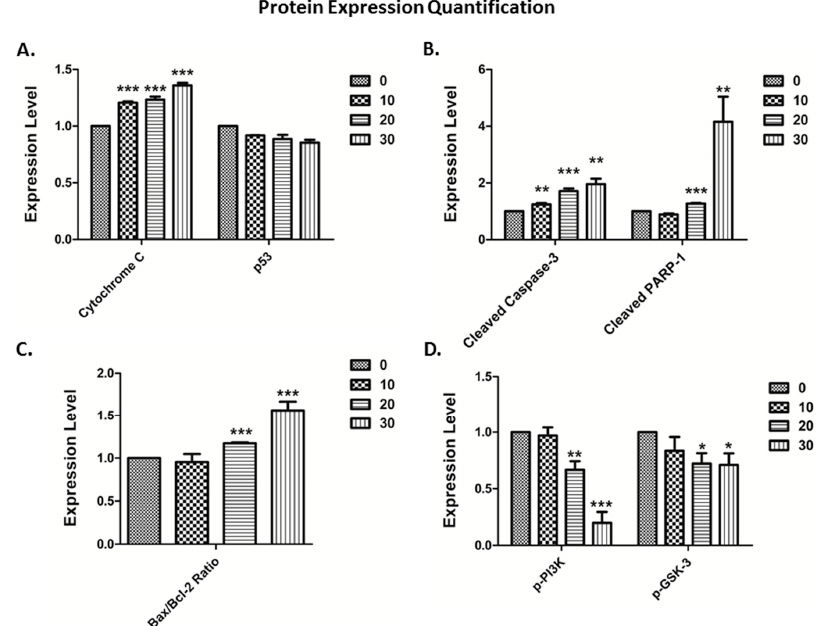
Figure 8. Quantification of apoptotic protein expression in MDA-MB-231 cells treated with beta-T3 vitamin E isomer for 24 h by the Image J software. Compared to control levels, beta-T3 significantly increased, on the one hand, cytochrome-c ( A ), cleaved caspase-3, cleaved-PARP-1 ( B ) and Bax/Bcl-2 ratio ( C ) expression levels. On the other hand, it significantly decreased the expression levels of two proliferation involved proteins p-PI3K and p-GSK-3 ( D ). *, ** and *** indicate p < 0.05, p < 0.001 and p < 0.0001 respectively.